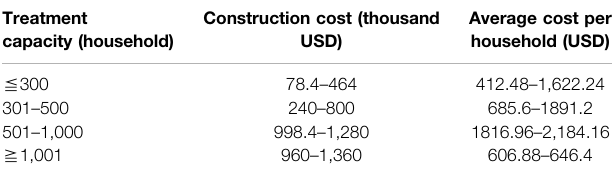
TABLE 4 | Construction cost for the CM of RDST.